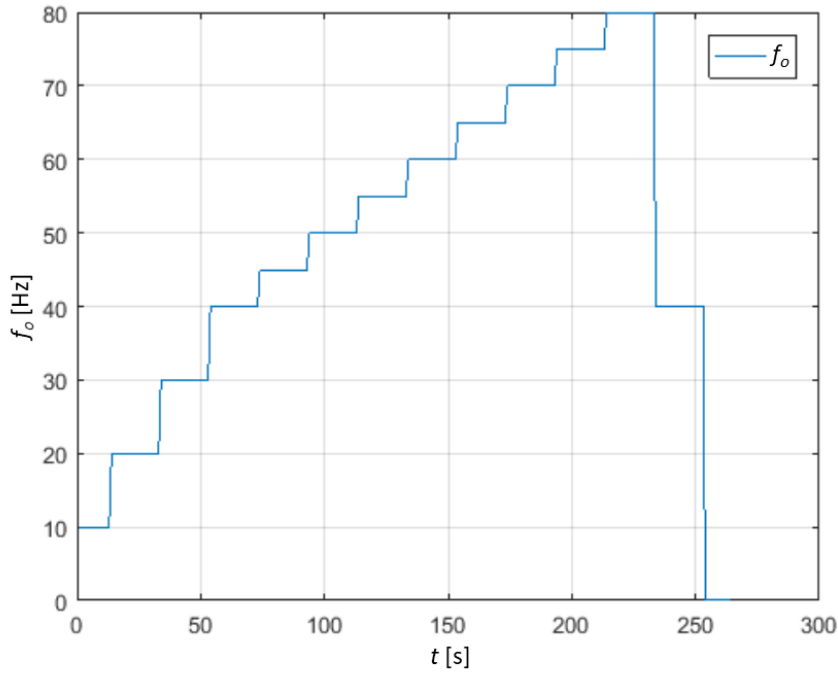
Figure 3. Schedule of the output frequency f o changes during identification experiments.